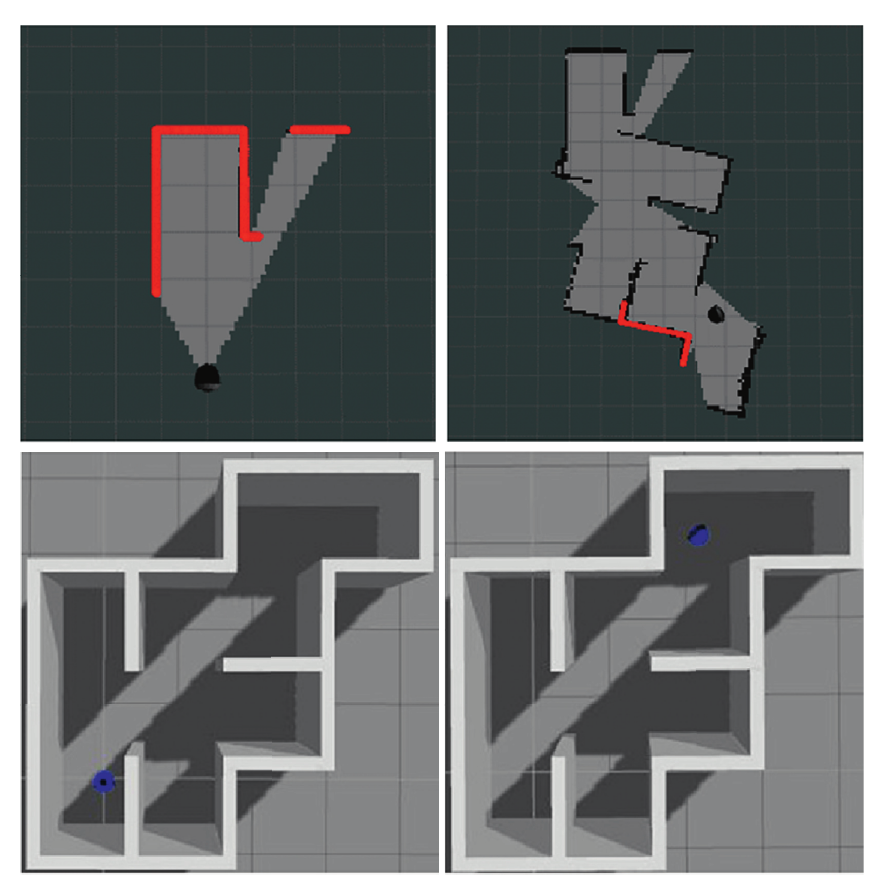
Figure 7: Mapping result of RBG-D